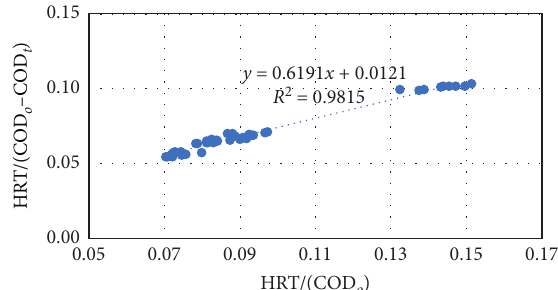
Figure 7: Stover–Kincannon model plot for COD removal in the pilot-scale MBBR.